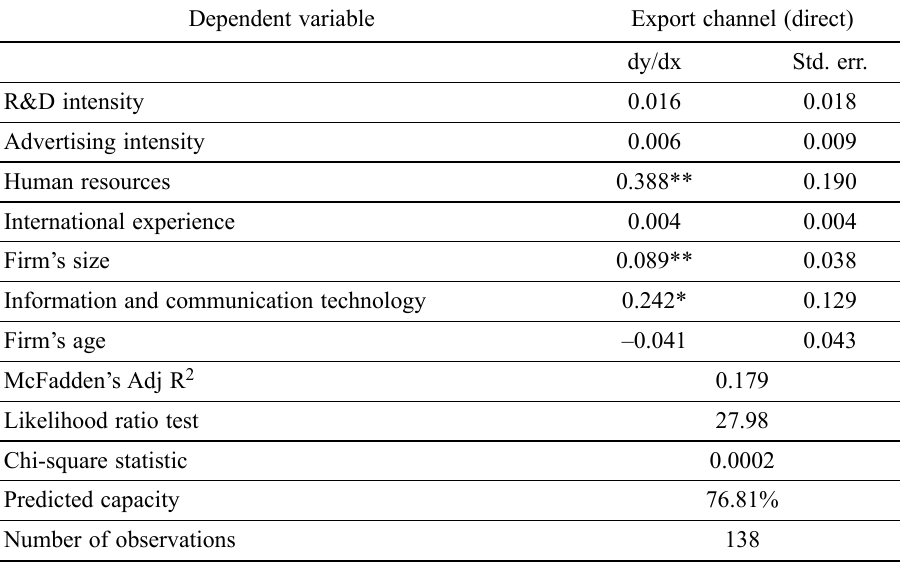
Table 3. Marginal effects for binary probit